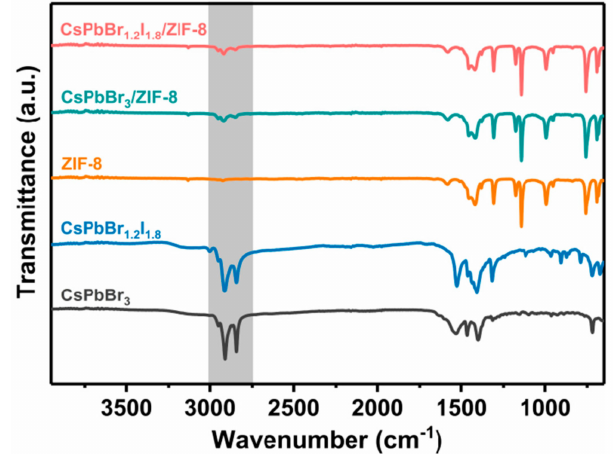
Figure 4. FTIR spectra of CsPbX 3 (X = Br, Br 0.4 I 0.6 ) QDs, ZIF-8, and CsPbX 3 / ZIF-8